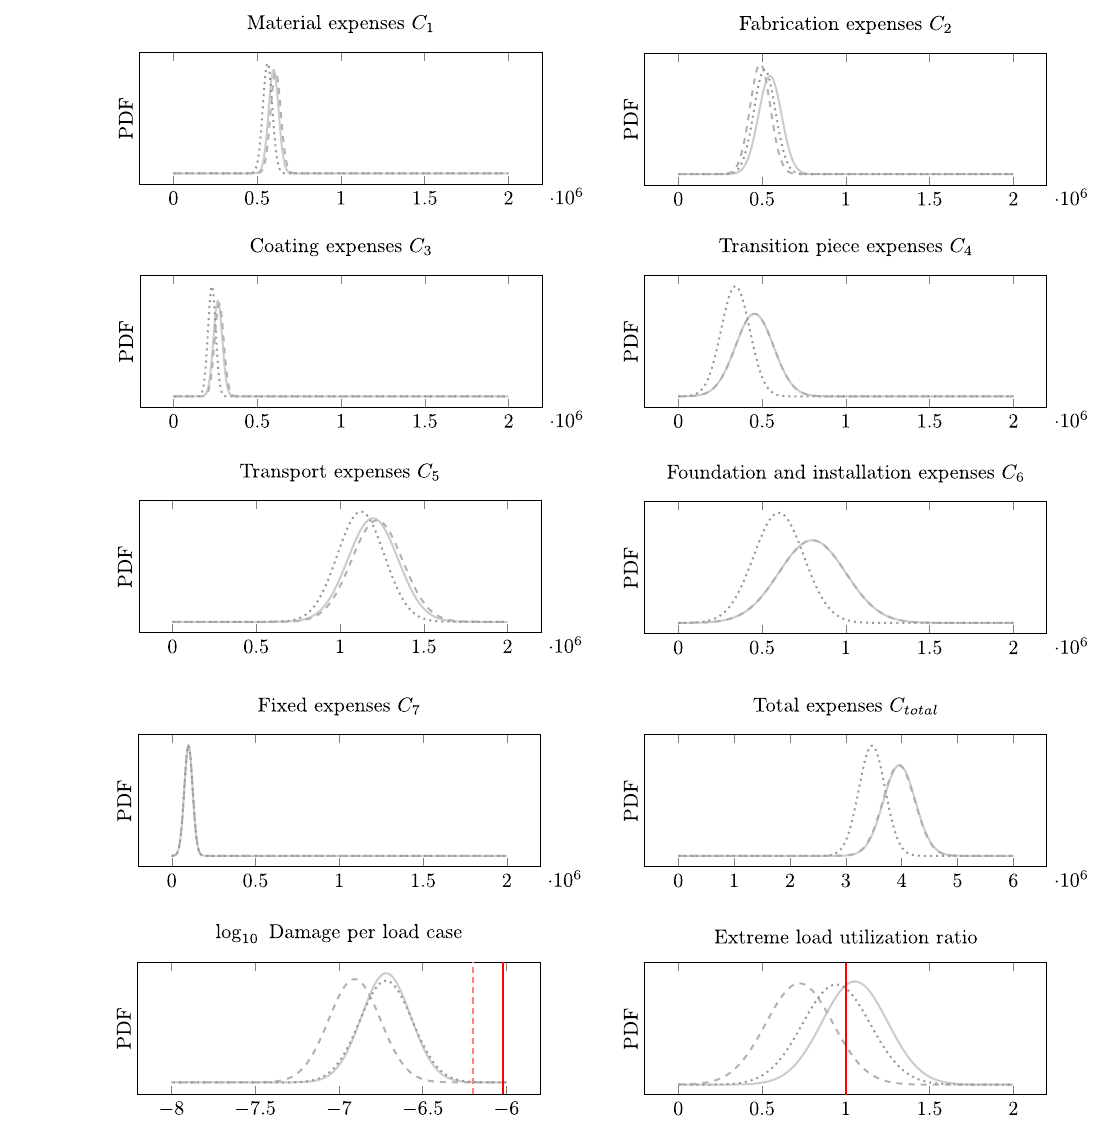
Figure 7. Probability density functions (PDFs) of the cost contributions C 1 ...C 7 , the total expenses C total , the (logarithmized) predicted damage per load case, and the predicted extreme load utilization ratio for the considered example case. Each plot shows the probability density depending on cost, damage exponent, and utilization ratio. Structure (1) is illustrated by the solid gray line, structure (2) by the dashed gray line, and structure (3) by the dotted gray line. The solid red line illustrates the critical damage related to a 20-year lifetime of the structure or a utilization ratio of 1. Moreover, the 30-year damage is illustrated with the dashed red